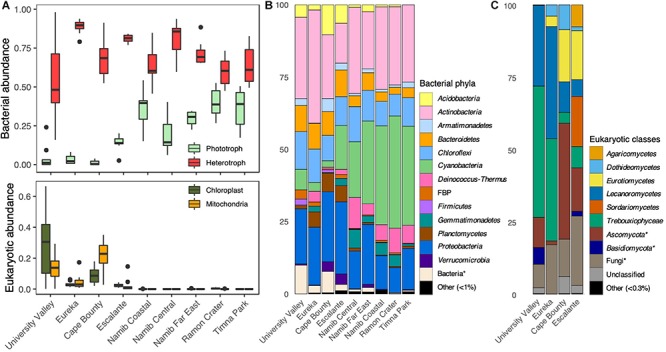
Sandstone endolithic community composition. (A) Top: Relative proportions of bacterial phototrophs (oxygenic and anoxygenic phototrophs) and heterotrophs, obtained from 16S rRNA gene sequences Bottom: Relative proportions of chloroplast and mitochondrial 16S rRNA gene sequences. (B) Prokaryotic community composition, based on 16S rRNA gene sequences. (C) Eukaryotic community composition based on ITS sequences. Asterisks indicate a lack of taxonomic information up to the designated level.